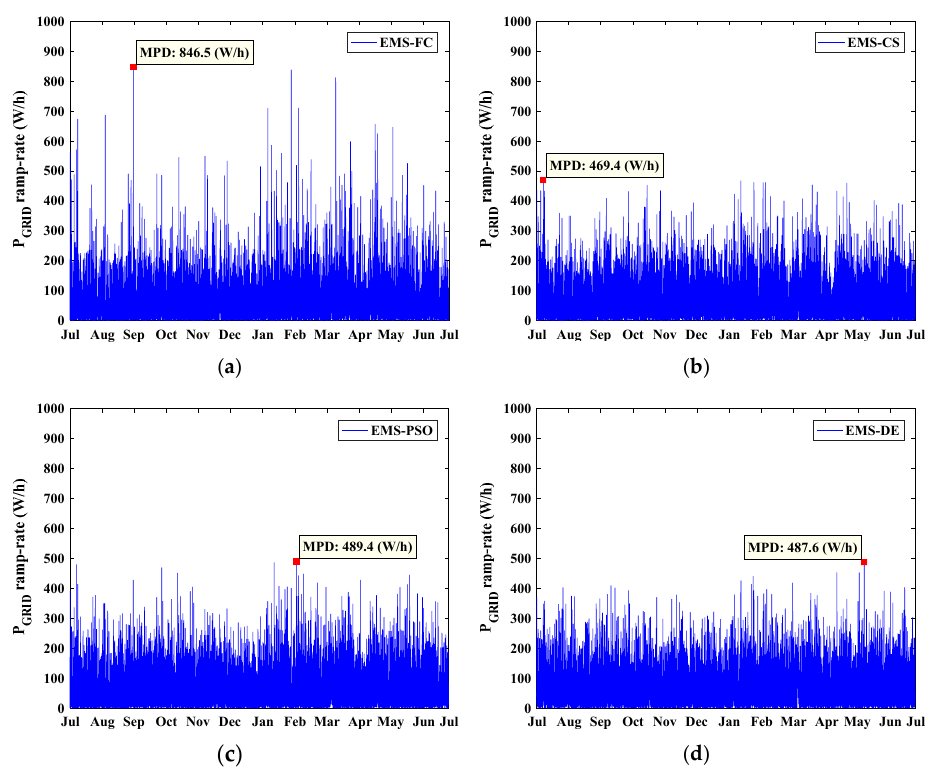
Figure 10. Grid power ramp-rates ( a ) EMS-FC, ( b ) EMS-CS, ( c ) EMS-PSO, and ( d ) EMS-DE.